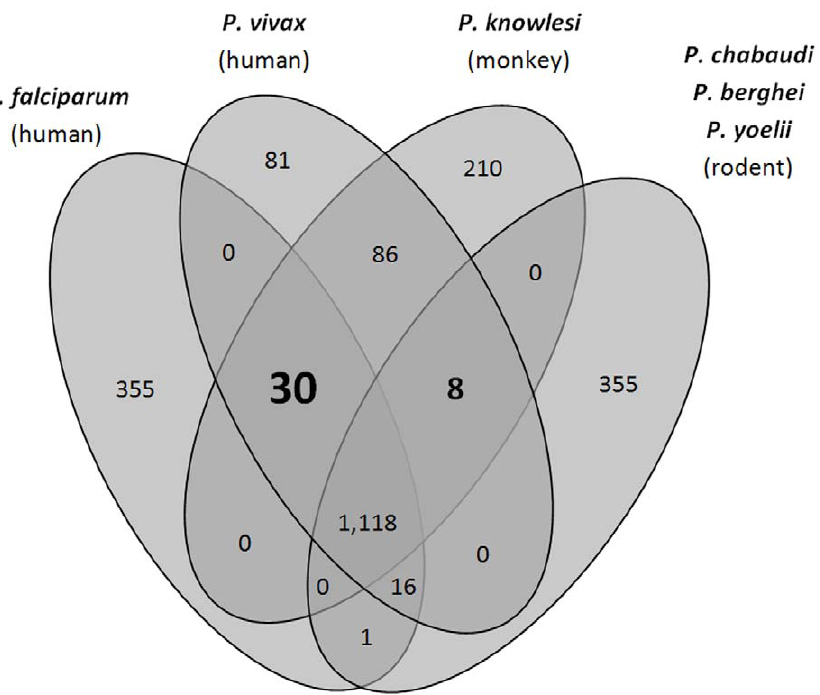
Figure 1. Proteome comparison reveals 30 proteins conserved in primate malaria parasites but absent in rodent malaria parasites. Genes were considered specific to a group of parasites if conserved in all in-group species (global protein sequence PID . =40) but not in any of the out-group species (PID , =15). In particular, primate-parasite specific genes are genes conserved in the three primate parasite proteomes but not in any of the three rodent parasite proteomes. The Venn diagram shows numbers of species subset-specific genes identified for all possible species combinations. Putative primate parasite-specific genes (30) are shown in bold. Note that gene numbers do not add up to species totals because genes with PIDs between 15% and 40% are not included.